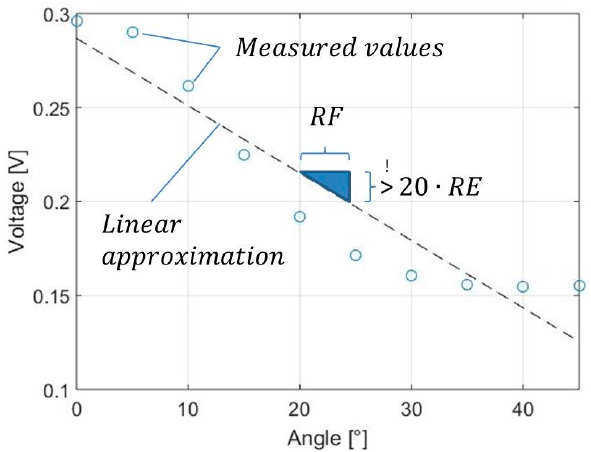
Figure 6. Linearization of orientation specific voltages for the determination of % RE